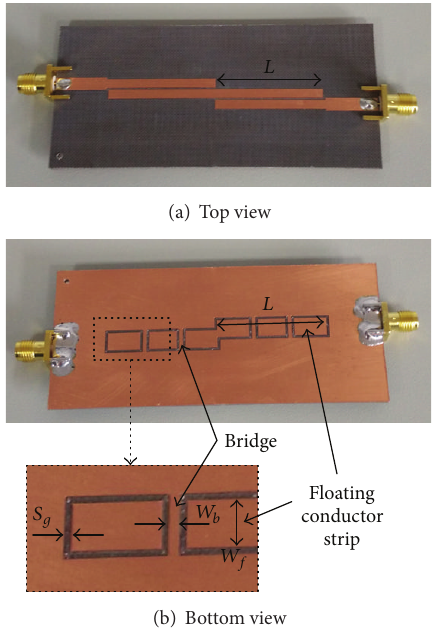
Figure 11: Photograph of the fabricated bandpass filter configured with the